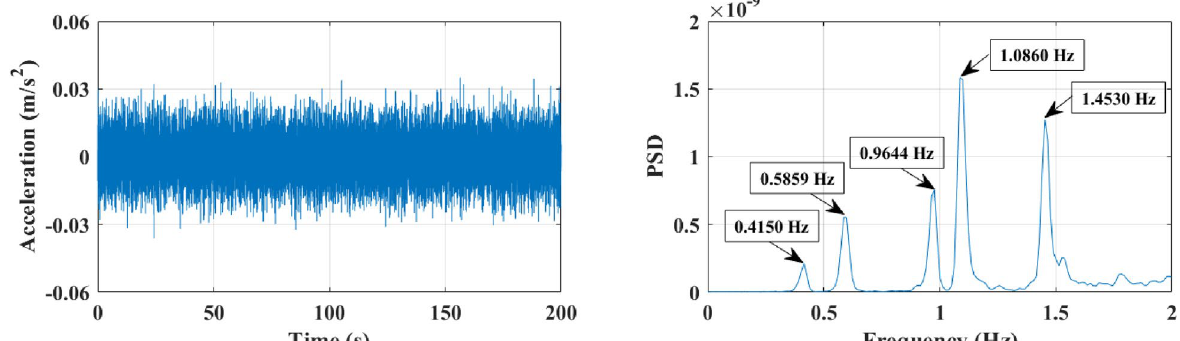
Fig. 11 Acceleration signal and its PSD